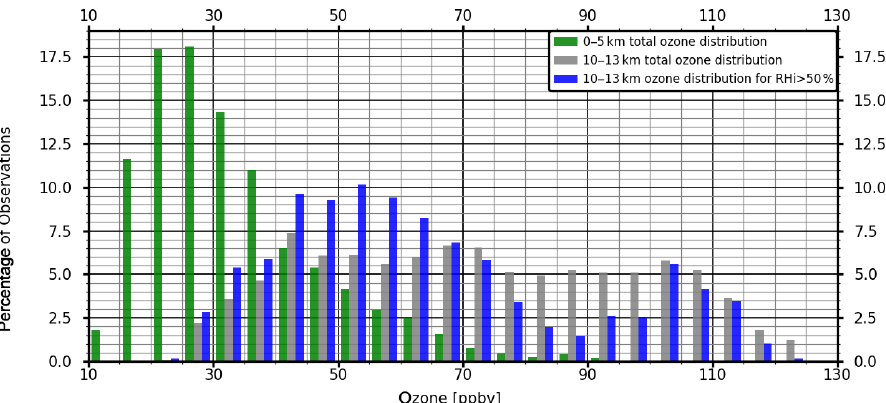
Figure 6. NDACC/SHADOZ ozone distribution in the lower troposphere (0–5km) shown in green. The total distribution in the upper troposphere (10–13km) is shown in grey and for moist data (10–13km and RH>50%) in blue. The distributions are based on 55 ozone profiles for austral summers 2014, 2015 and 2016. The mean values for each distribution are 73.8, 57 and 33.5ppbv for the 10–13 total ozone distribution, 10–13km ozone distribution with RH>50% and 0–5km total ozone distribution, respectively.